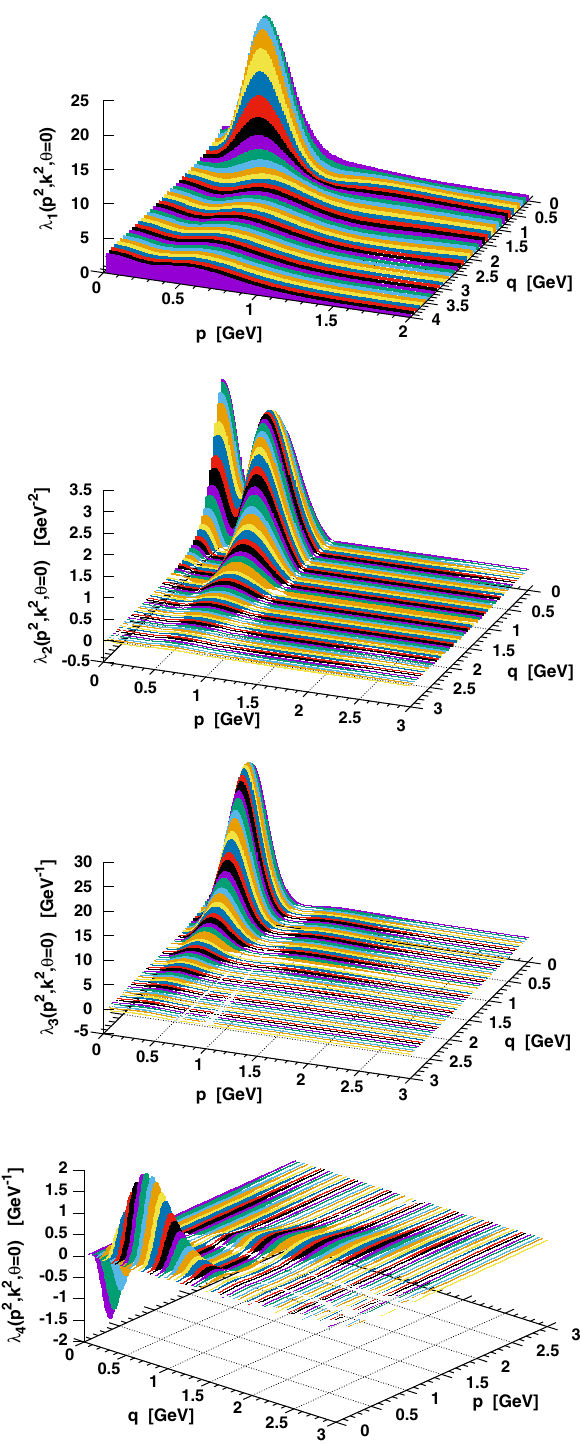
Fig. 36 Longitudinal quark-gluon form factor for θ = 0